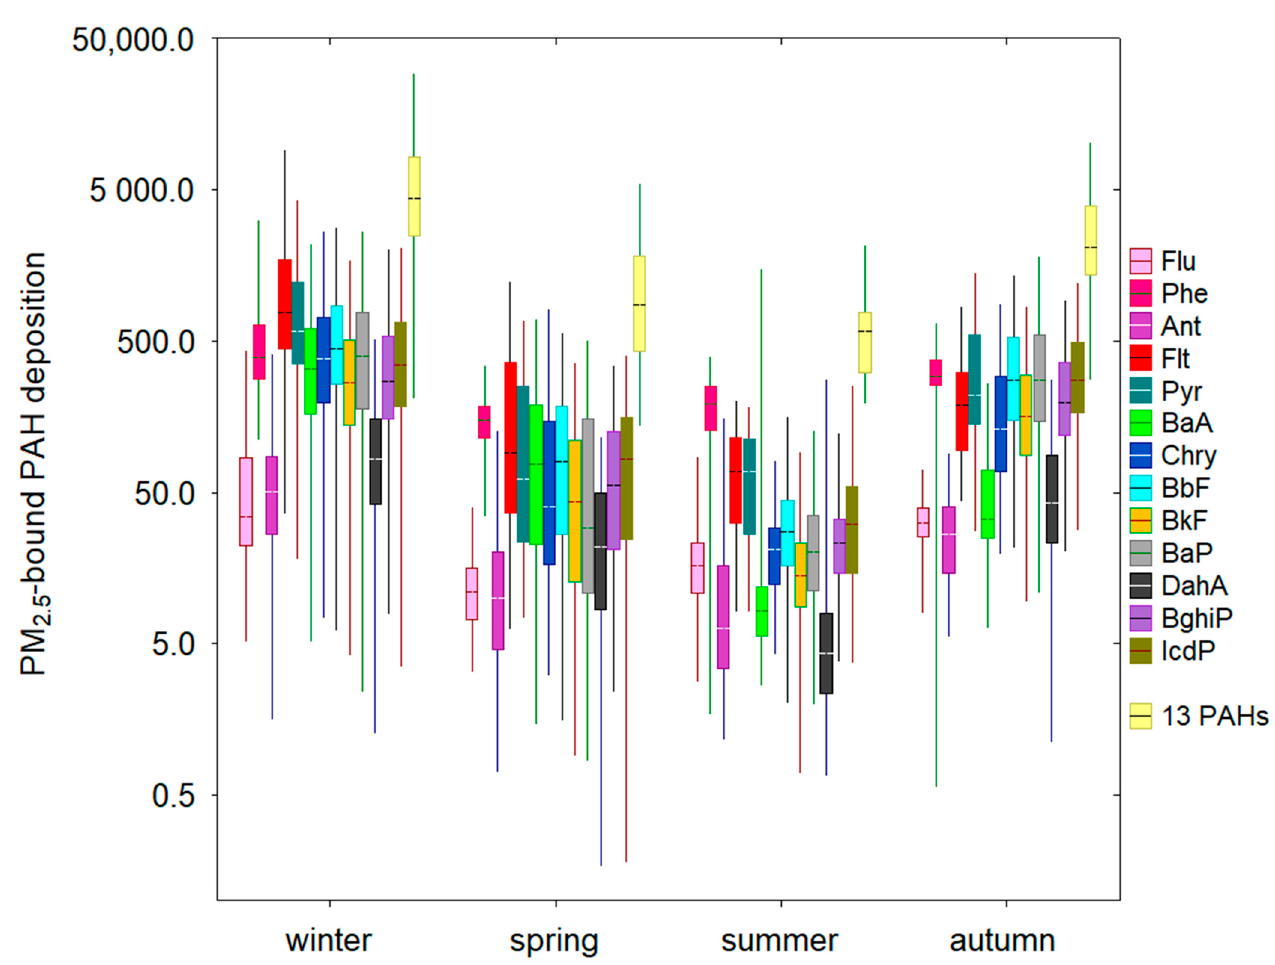
Figure 1. Seasonal boxplots of PM 2.5 -bound PAH deposition fluxes in the coastal urban region in northern Poland, 2019. Box edges denote the 25th and 75th quartiles, the median value is indicated as a vertical line inside boxes, and whiskers stand for minimum and maximum.